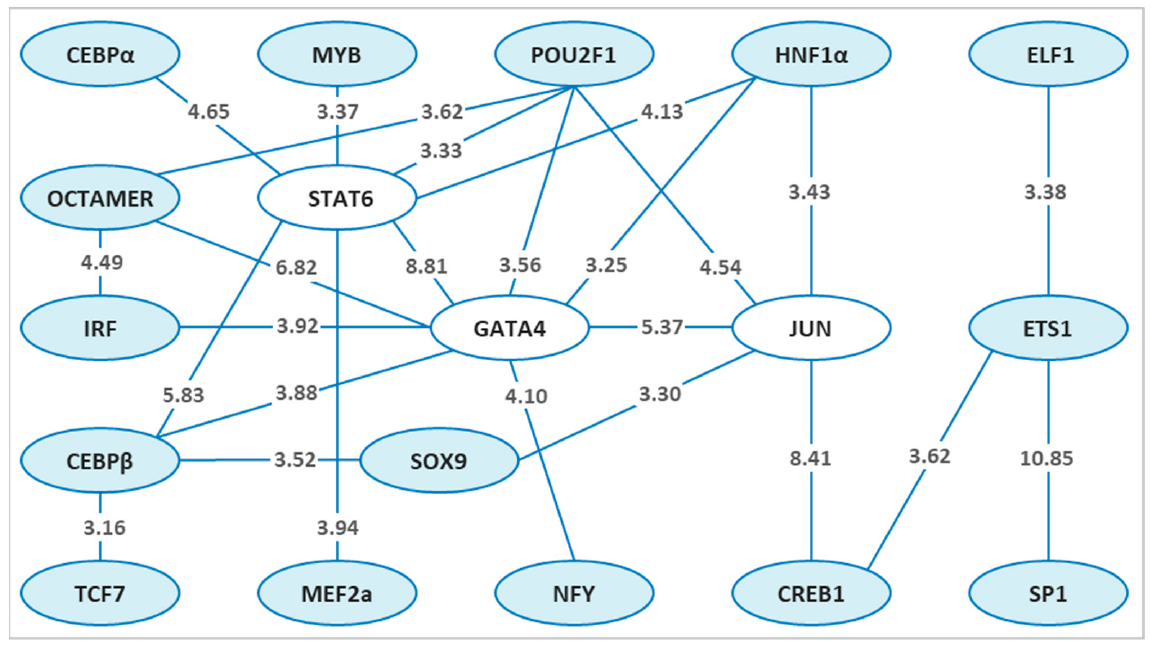
Figure 2. The significant specific transcription factor pairs for sex determination genes in zebrafish. Nodes represent the identified transcription factors for sex in blue or white, and edges represent their potential cooperation. The top three highly connected transcription factors (hubs) in the network are shown in white. The z-score for each transcription factor pair is illustrated on the connecting line.